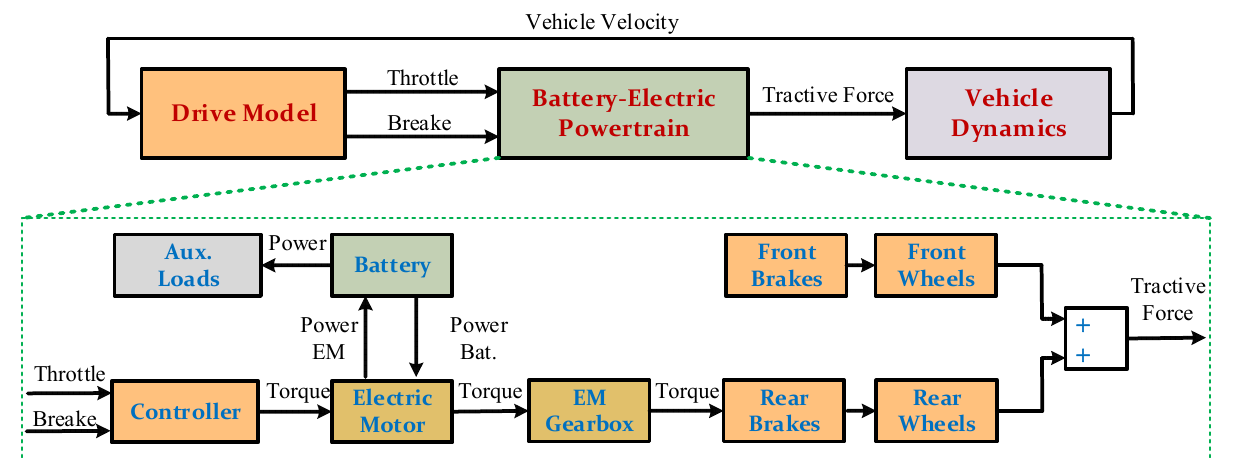
Figure 4. Composition of the BEB simulator model [59].